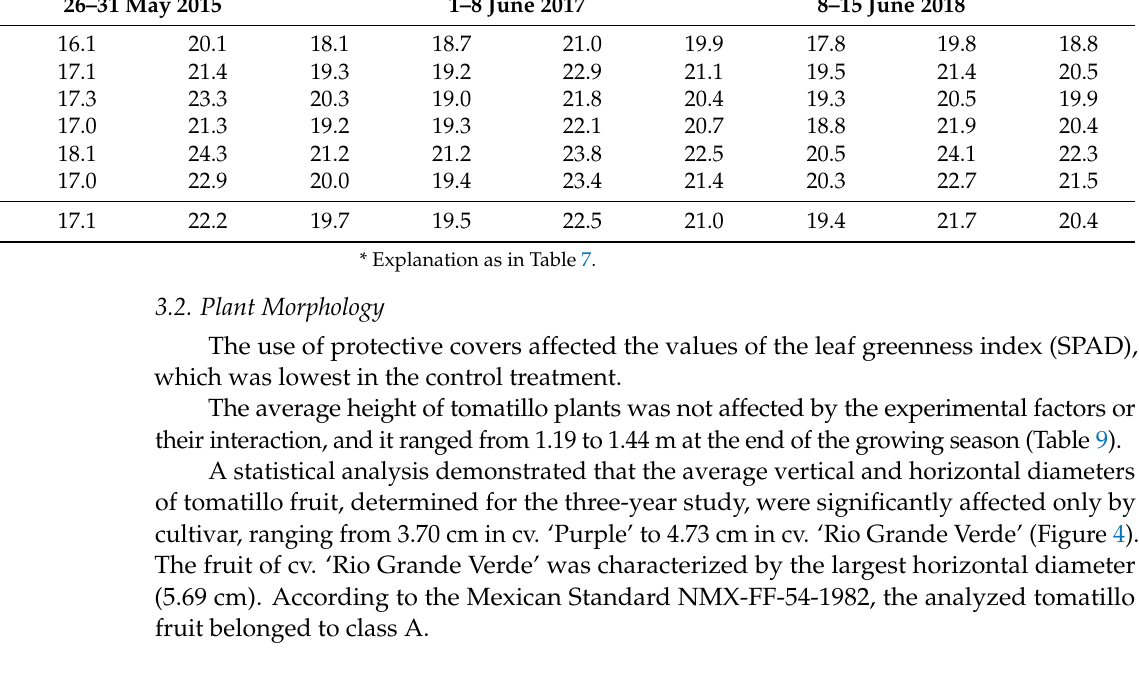
Time of Measurement